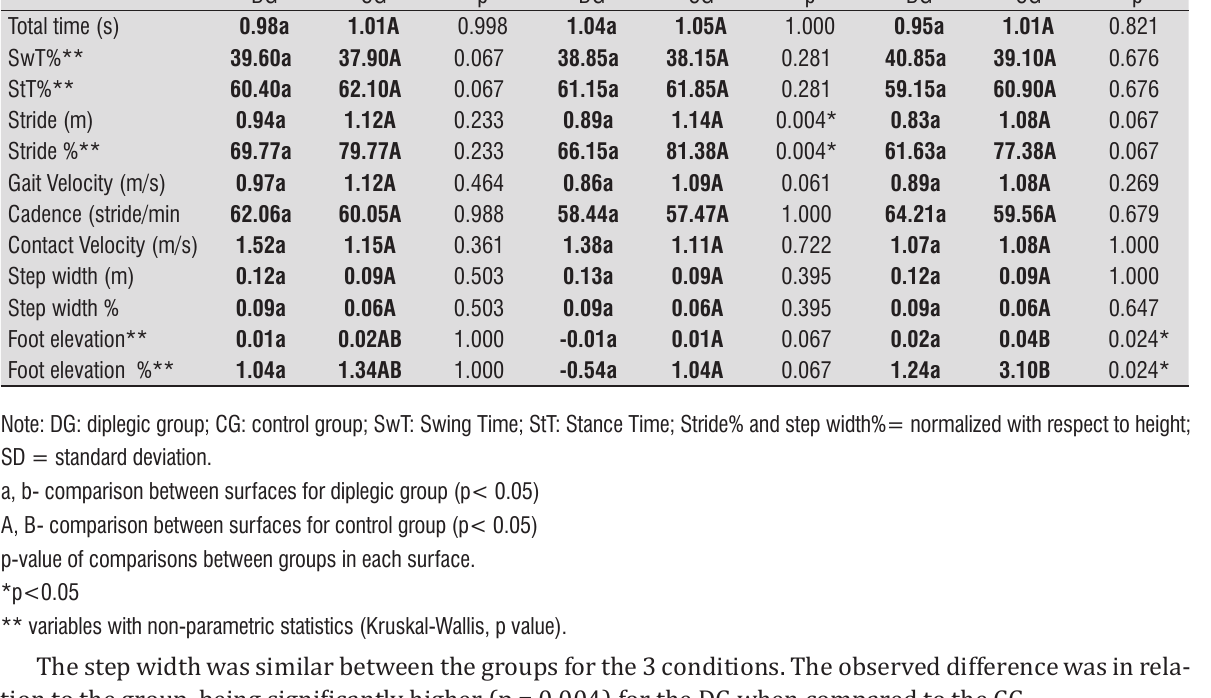
Table 1 - Gait spatial and temporal linear variables (mean) of children with spastic diplegic (DG) and control group (CG) during horizontal, ascent and descent surface Horizontal Ascent